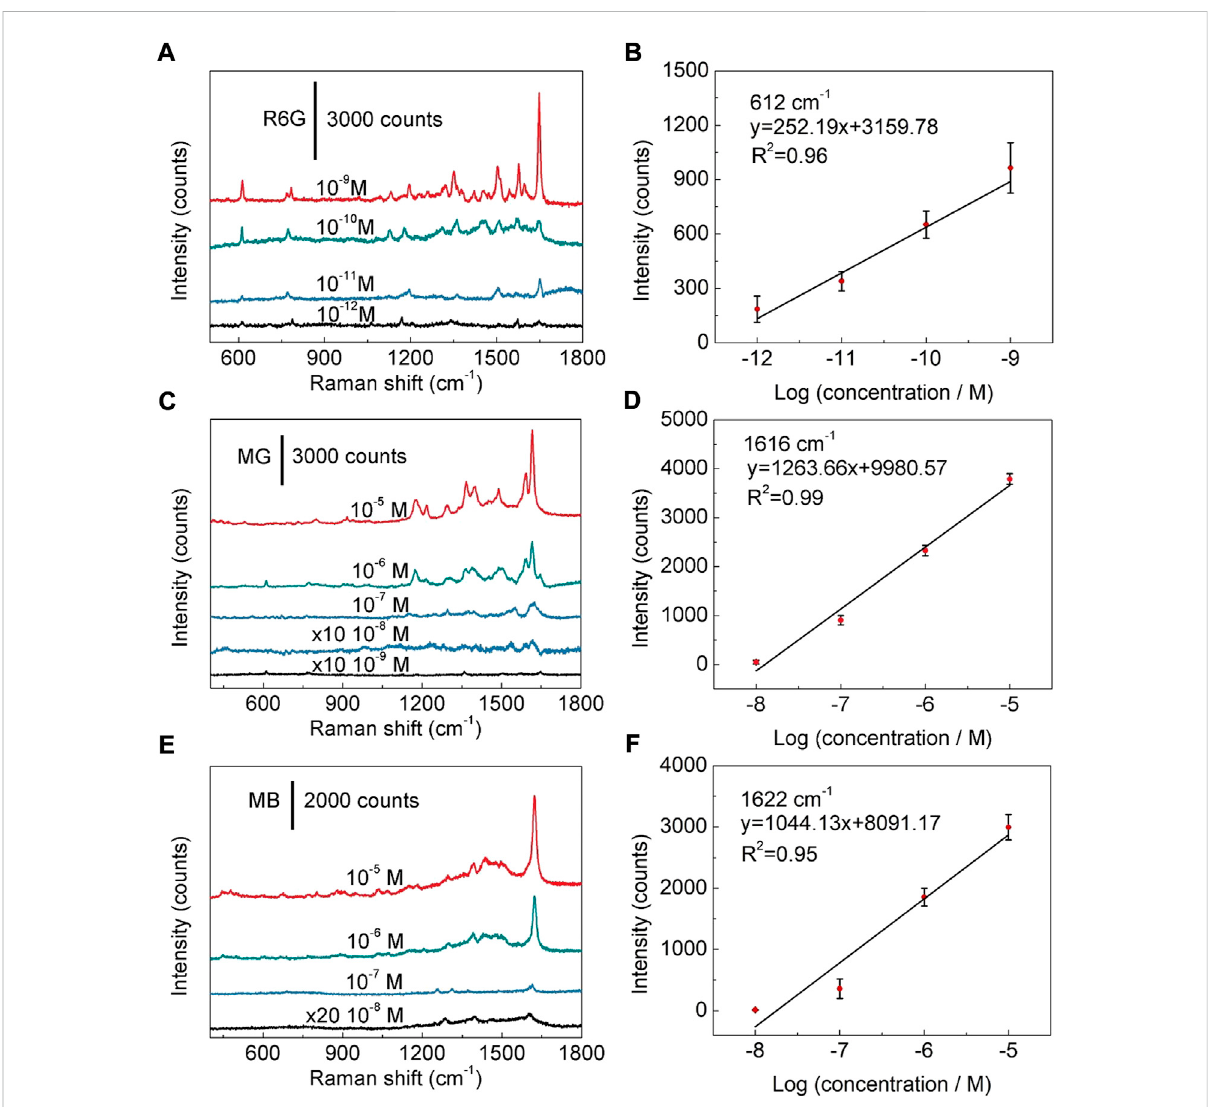
FIGURE 4 SERSsensitivity to organic dyes. (A) SERS spectra of R6G atconcentrationsof 10 − 9 M-10 − 12 M. (B) Linear relationshipbetween thepeak intensity andthelogarithmicconcentrationofR6G. (C) SERSspectraofMGatdifferentconcentrationsfrom10 − 5 Mto10 − 9 M. (D) Linearrelationship between the peak intensity and logarithmic concentration of MG. (E) SERS spectra of MB with the concentration ranging from 10 − 5 M to 10 − 8 M. (F) Linear relationship between the band intensity and logarithmic concentration of